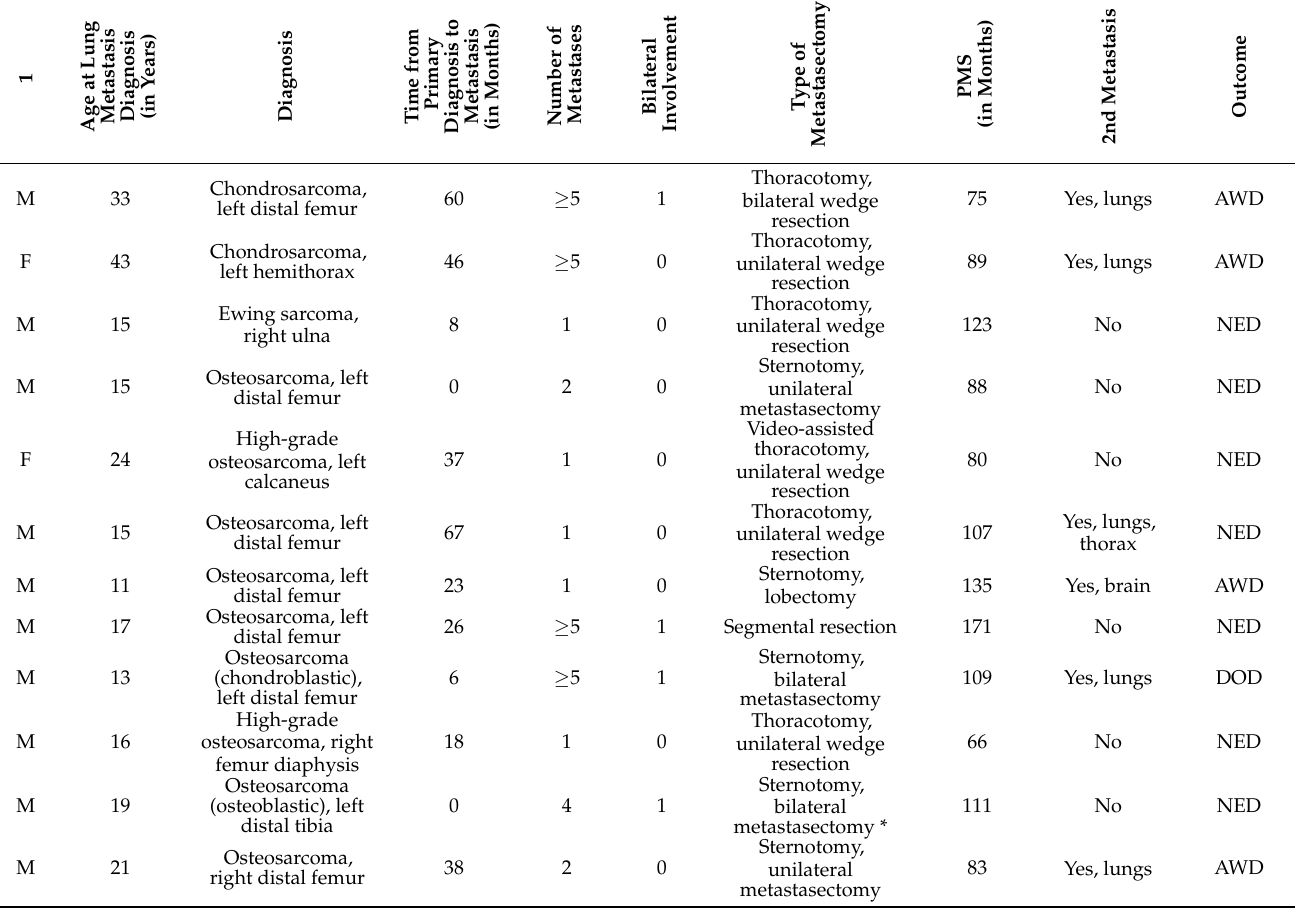
Table 3. Long-term survivors following pulmonary